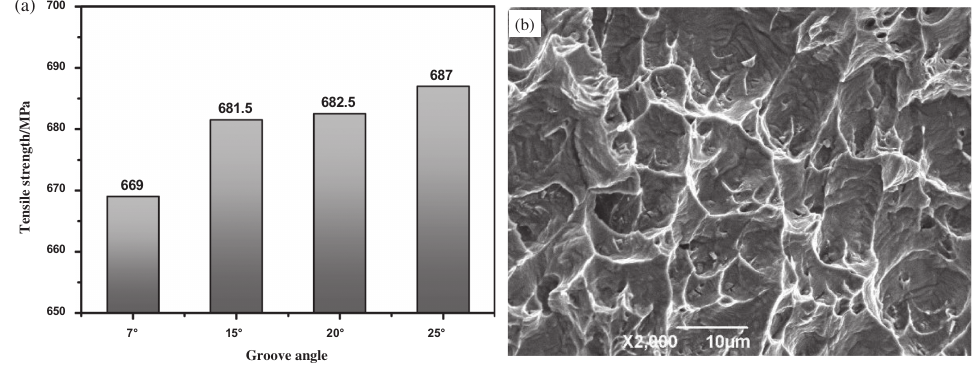
Figure 5: T92/Super 304H dissimilar weld joints (a) tensile test and (b) fracture morphology.